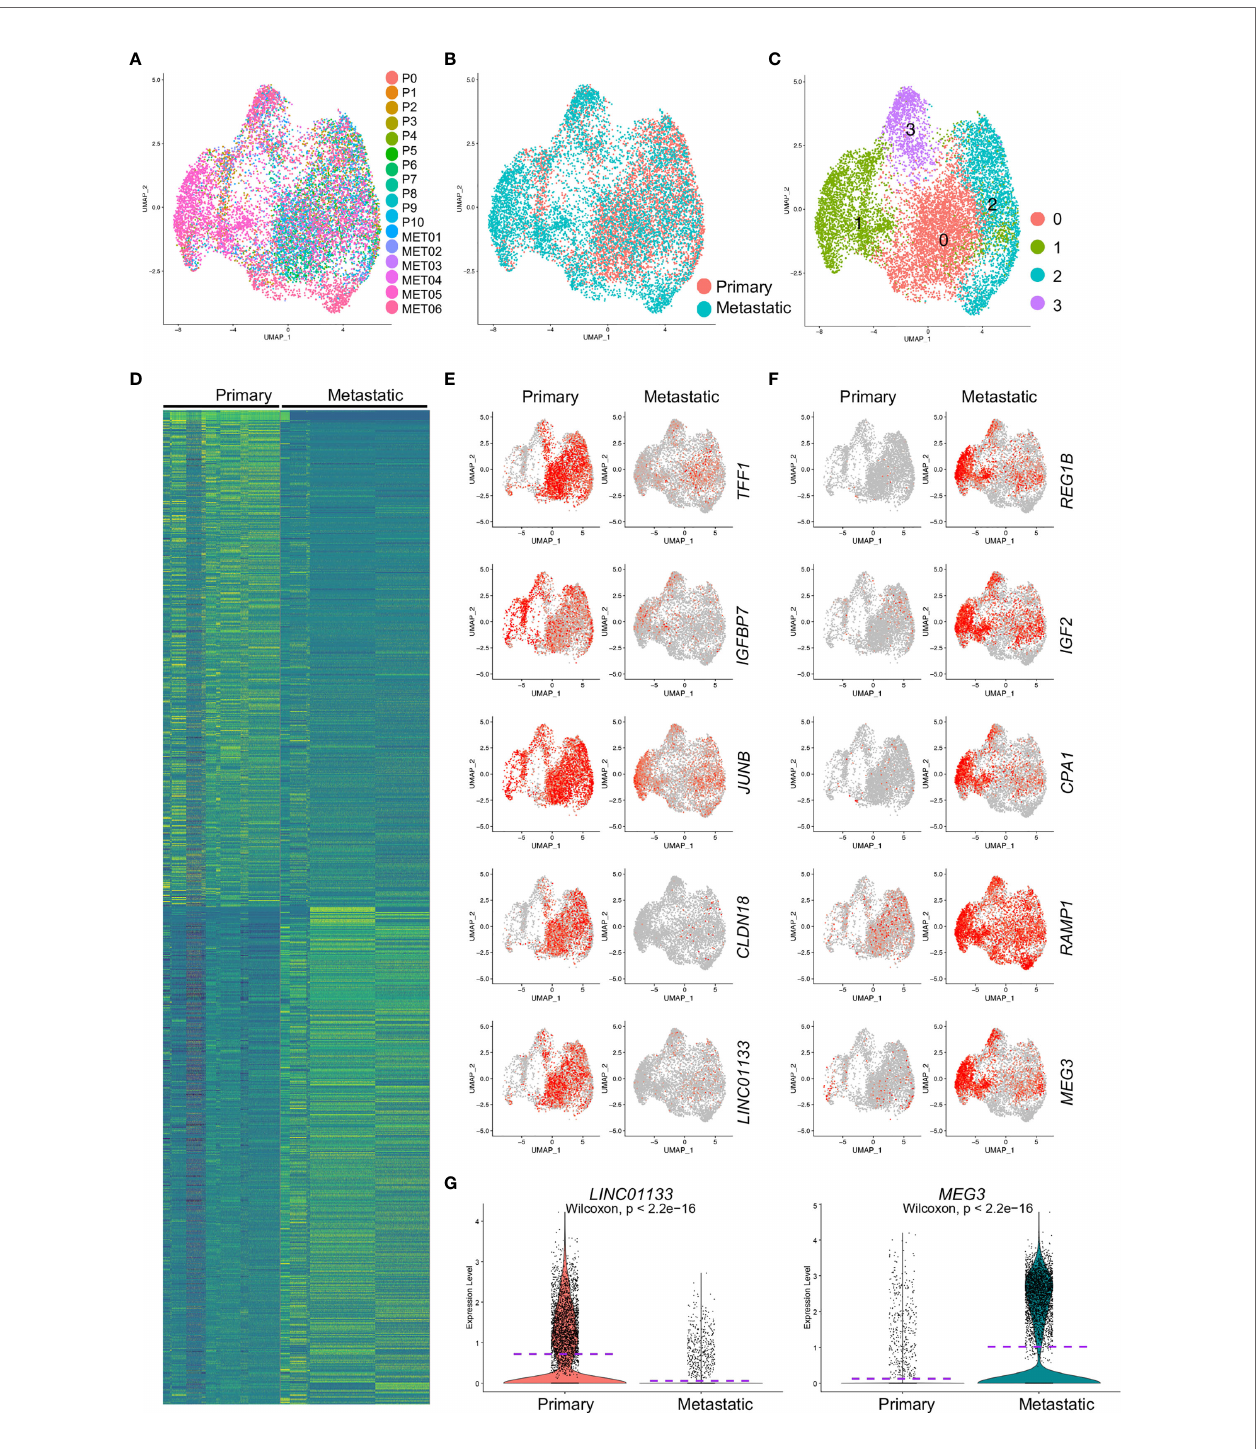
FIGURE 2 | Differentially expressed gene analysis of cancer cells from primary and metastatic PDAC. Cancer cells were extracted and clustered. (A) The distributions of each tumor sample were visualized. (B) The distribution of primary and metastatic PDAC cancer cells in extracted cancer cell data. (C) Cancer cell were clustered, and four clusters (Clusters 0 – 3) were identi fi ed. Comparative analysis was performed to calculate the DE genes between primary and metastatic PDAC cells. (D) Top 500 DE genes of both primary and metastatic PDAC cancer cells were visualized by heatmap. (E, F) Expression of representative top fi ve genes of primary (E) and metastatic (F) PDAC cancer cells was visualized by UMAPs to compare their expression in primary and metastatic PDAC cancer cells. Notably, lincRNAs, LINC01133 and MEG3 , showed speci fi c expression in primary and metastatic PDAC cancer cells, respectively. (G) Violin plot visualization of expression levels of LINC01133 and MEG3 expression in primary and metastatic PDAC cancer cells. Dash purple lines indicated the Mean levels of gene